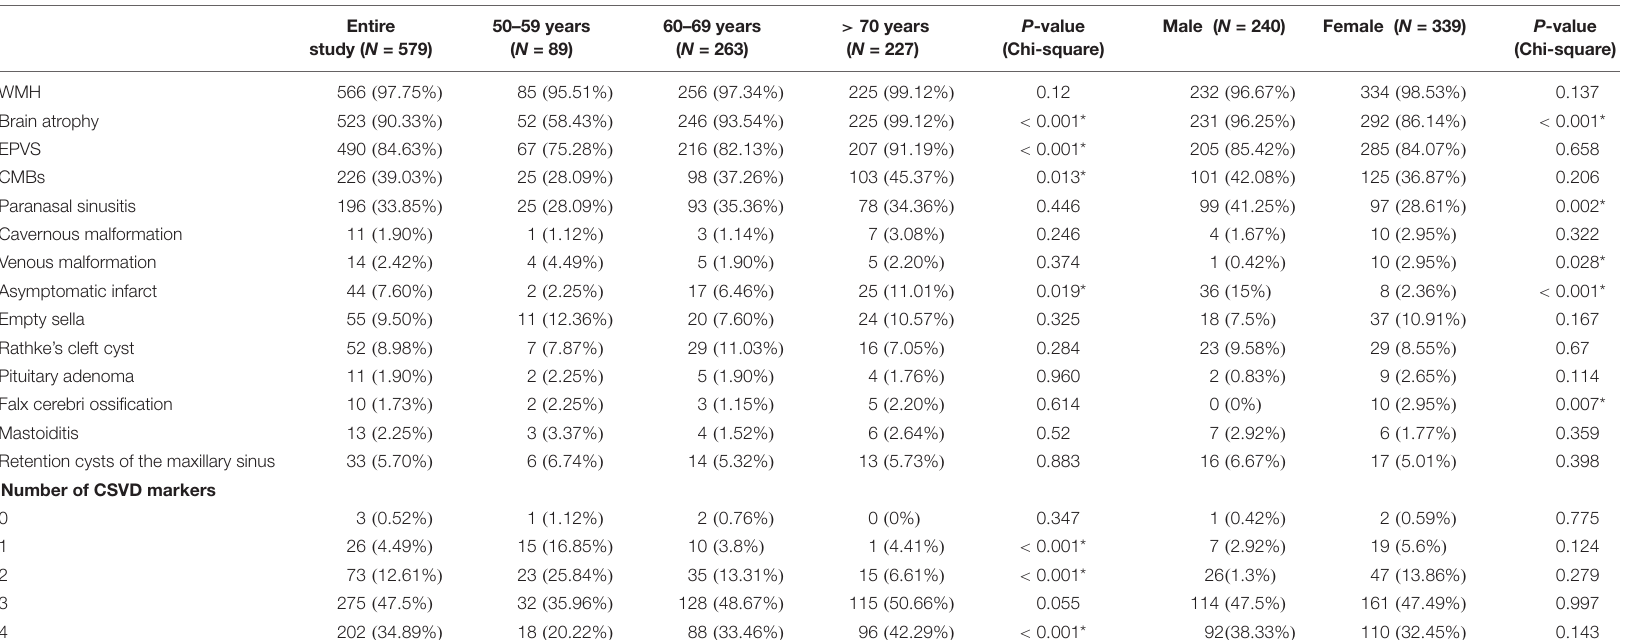
TABLE 5 | Distribution of incidental findings by age and